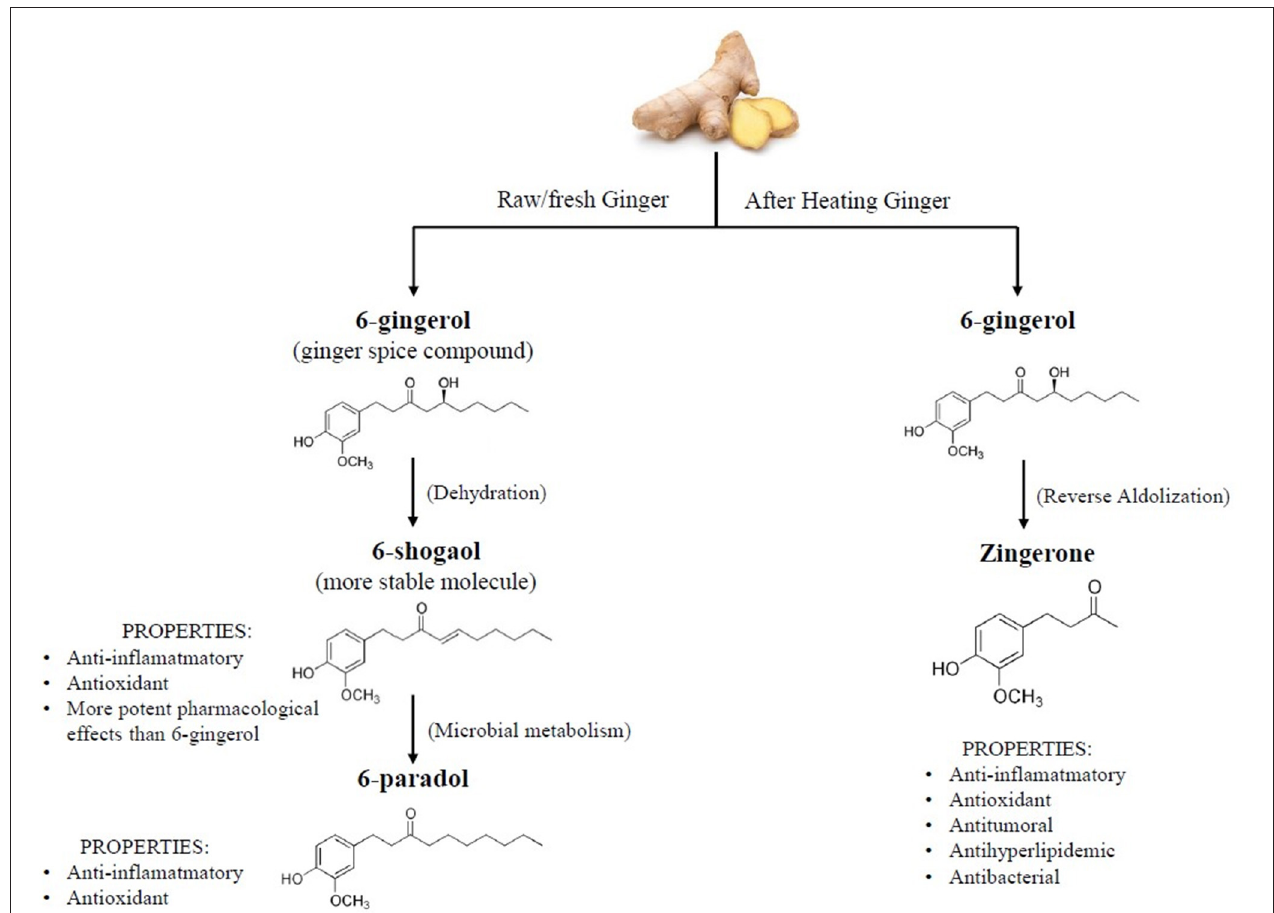
FIGURE 1 | Chemical structures and properties of ginger bioactive